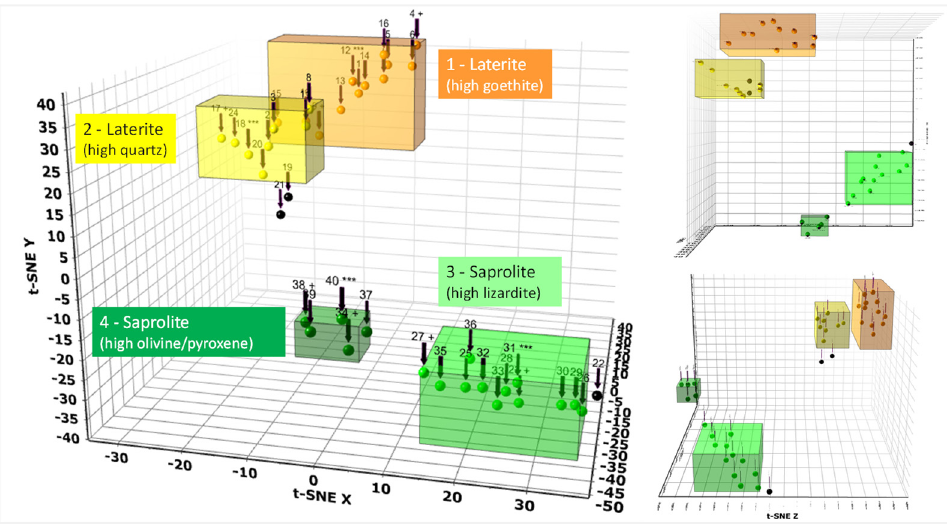
Figure 5. 3D t-SNE score plot after data clustering of 40 samples, visuals from 3 different angles.